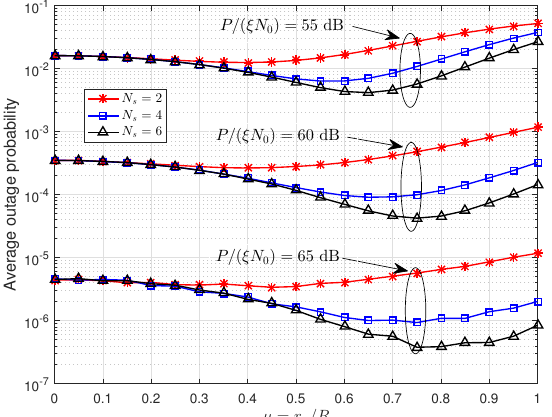
Figure 8. The effect of relay location on the average outage